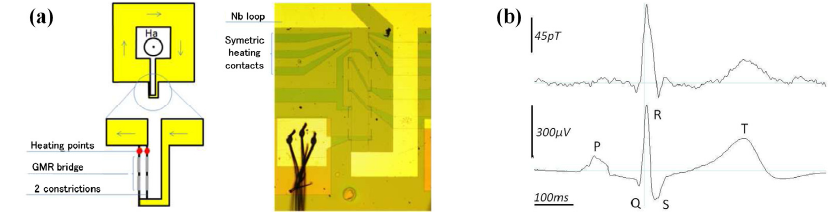
Figure 14. ( a ) Schematic of an antiparallel mixed sensor; ( b ) Simultaneous recordings of MCG ( top ) and ECG ( bottom ) averaged during 30 s with the mixed sensor reported in [84].